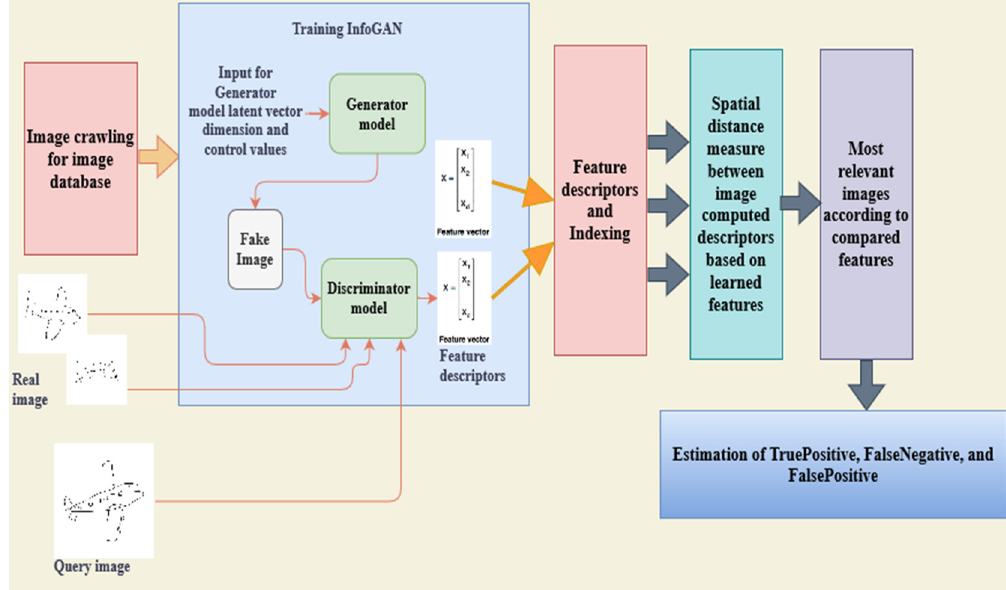
Figure 1. Proposed image retrieval system using InfoGAN.